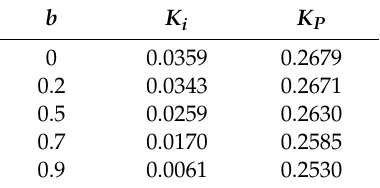
Table 1. PI controller parameters.